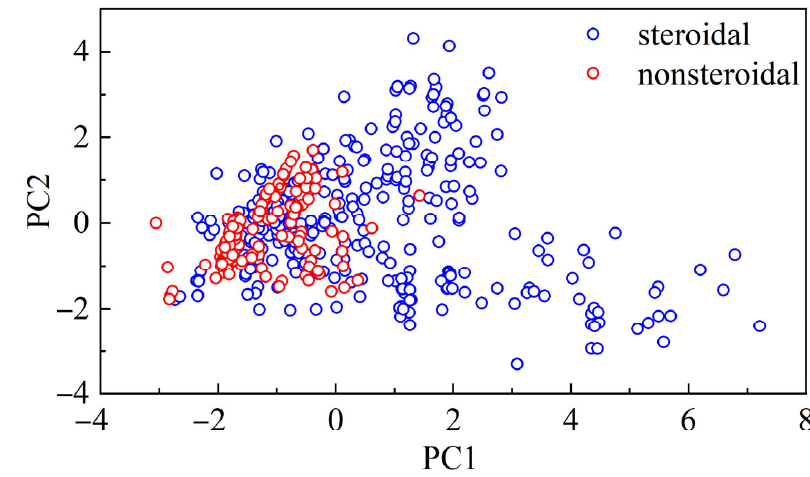
Figure 2. Chemical space occupied by nonsteroidal molecules (blue circle) and steroidal molecules (red circle) and spanned by the first two principal components (PC1 and PC2). The analysis was performed for all molecules regardless of their bioactivity classes. The detailed compositions of PC1 and PC2 are provided in Table 2. In comparison with nonsteroidal data, steroidal data were centered in a much smaller area. Table 2. Compositions of the top three principal components in terms of the six properties and the accumulated variance.